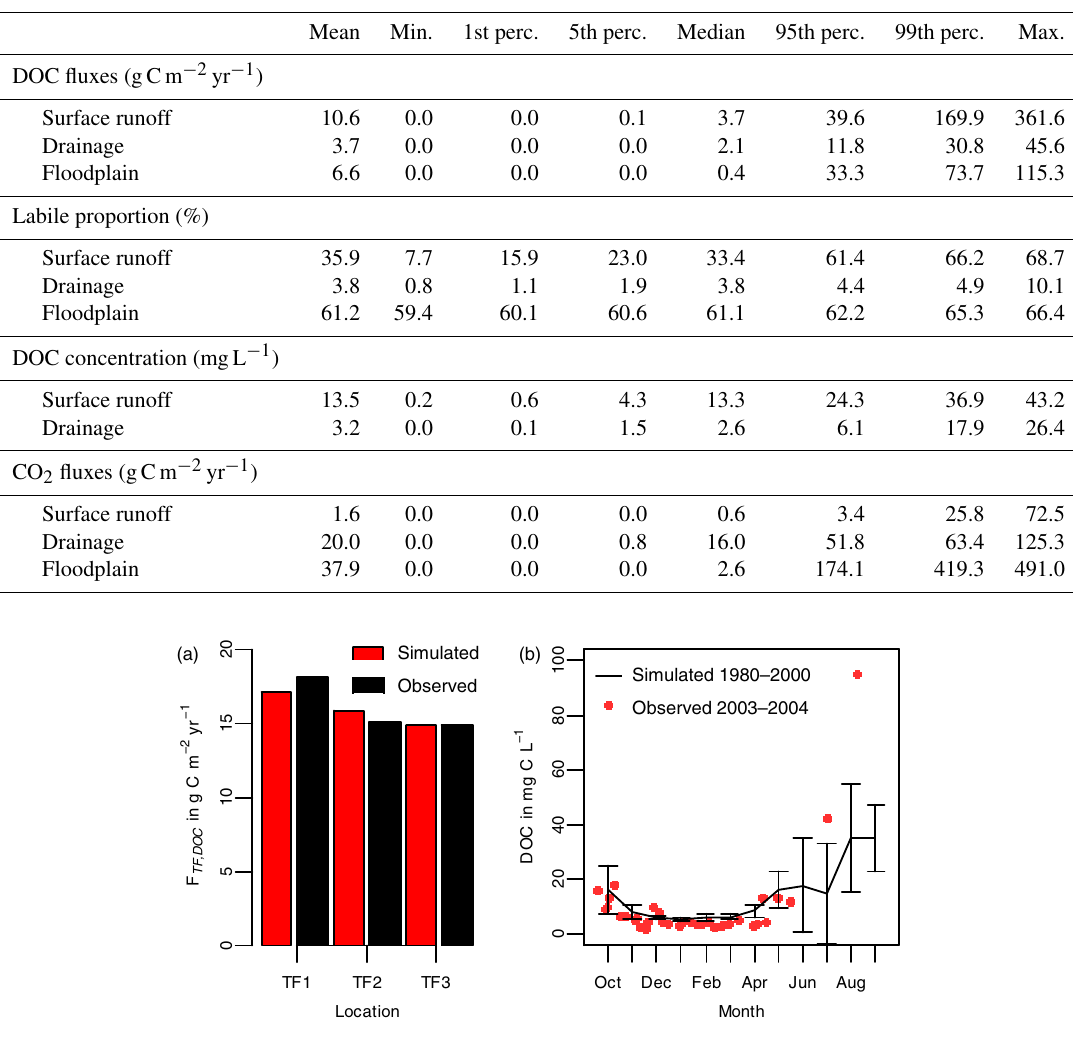
Figure 12. Simulated versus observed DOC in throughfall ( F TF ). (a) Yearly-mean throughfall DOC flux versus literature values for the following three locations: (1) north-west Amazonia (TF1 in Fig. 4) – Tobon et al. (2004); (2) lower Rio Negro (TF2 in Fig. 4) – Filoso et al. (1999); (3) southern Amazonia (TF3 in Fig. 4) – Johnson et al. (2006). (b) Seasonality in throughfall DOC concentrations for the site in southern Amazonia (TF3, Johnson et al., 2006). Note the sharp concentration increase during dry season from May to September. As the sampling period is outside of our simulation period, we compare the observed concentration with simulated average DOC concentrations over the entire run